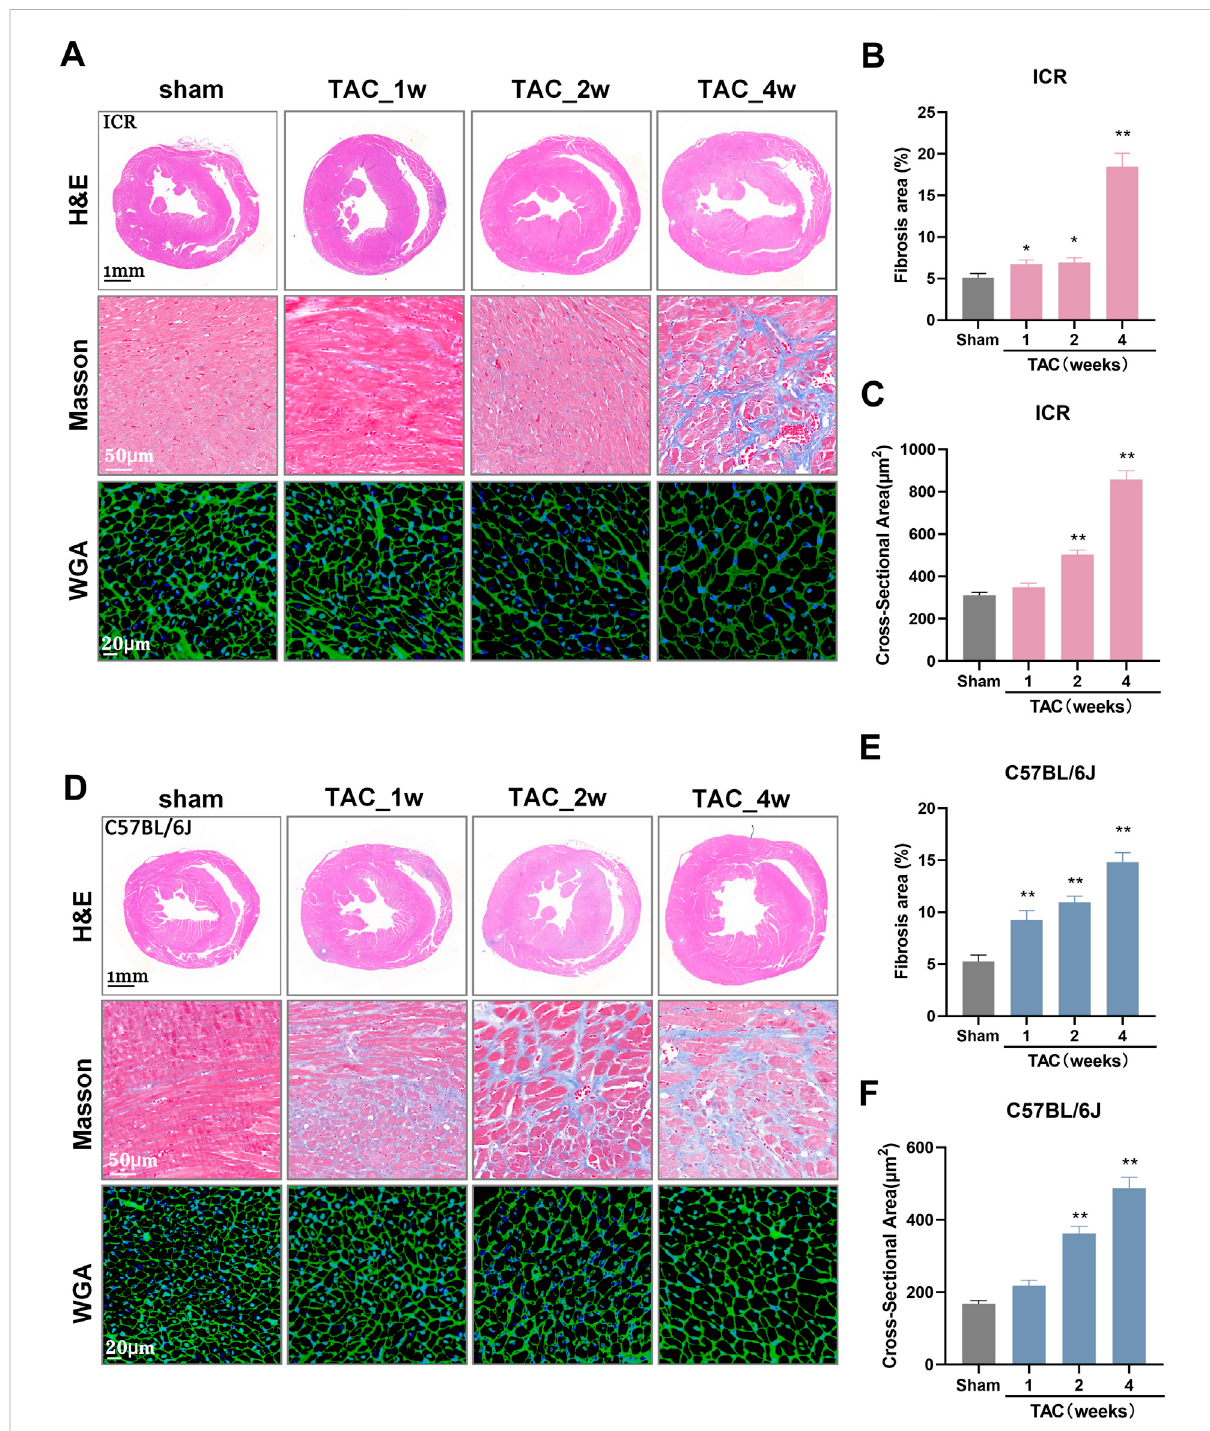
Histological alterations of mouse hearts at 1, 2, and 4 weeks post-TAC surgery in ICR and C57BL/6J mice. (A) Representative images of H&E- stainedheartsections(upperpanel),scalebar=1 mm;Massontrichrome-stainedleftventricletissues(middlepanel),redstaindenotesmuscle fi bers whilebluestaindenotescollagen.Whitescalerepresents50 μ m;Wheat-germ-agglutinin(WGA)-stainedcardiomyocytesborder(lowerpanel),scale bar=20 µm.AllimagesobtainedfromICRmice. (B) Quantitativeanalysisofinterstitial fi broticareameasuredfromMasson-stainedpicturesand (C) Cardiomyocyte cross-sectional area measured from WGA-stained pictures in ICR mice. (D – F) The same indicators of (A – C) in C57BL/6J mice. N = 3 per group per staining. Quantitative data are shown as mean ± SEM, ** p < 0.01 vs.